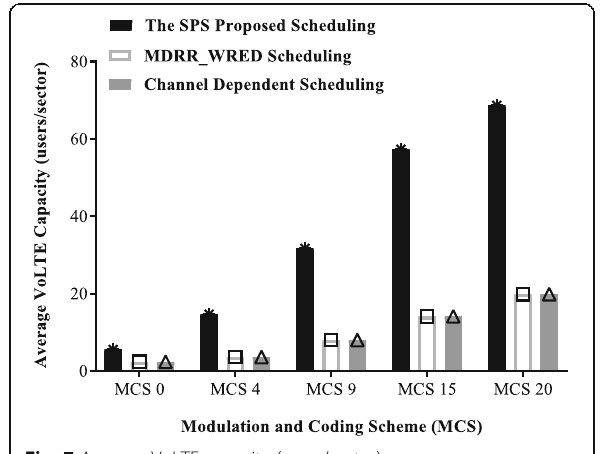
Fig. 7 Average VoLTE capacity